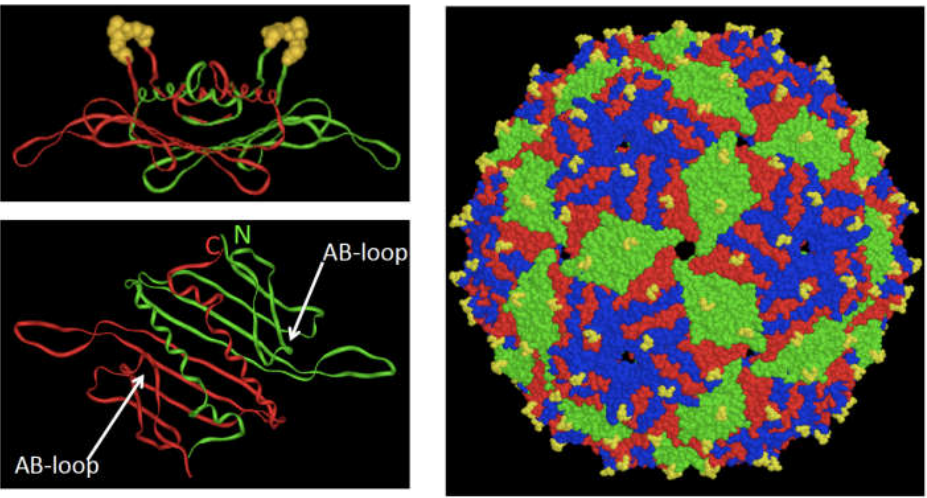
Figure 1. The structure of RNA phage coat proteins and VLPs as exemplified by MS2. At the bottom left is a top-down view of the coat protein dimer. Note the proximity of N- and C-termini of the two subunits, which facilitated construction of a single-chain dimer, and the locations of the AB-loops. At the top left is a side-view of the dimer with its AB-loops in yellow space-fill. On the right, the structure of the VLP showing the density of display of AB-loop surface display (yellow).